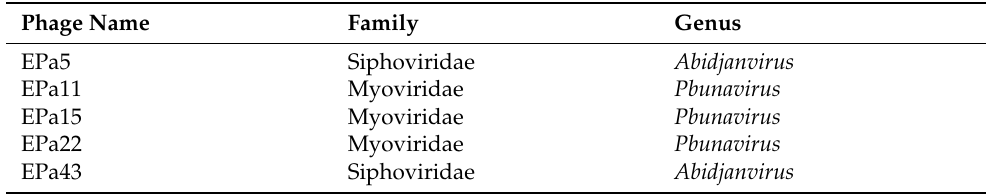
Table 6. P. aeruginosa phages in the PAM2H